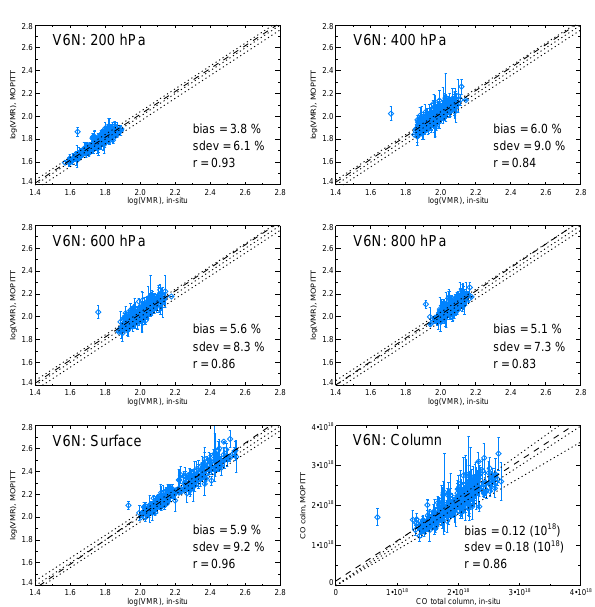
Figure 4. Scatterplots showing V6 NIR-only (V6N) validation re- sults based on NOAA profiles. See caption to Fig. 3.